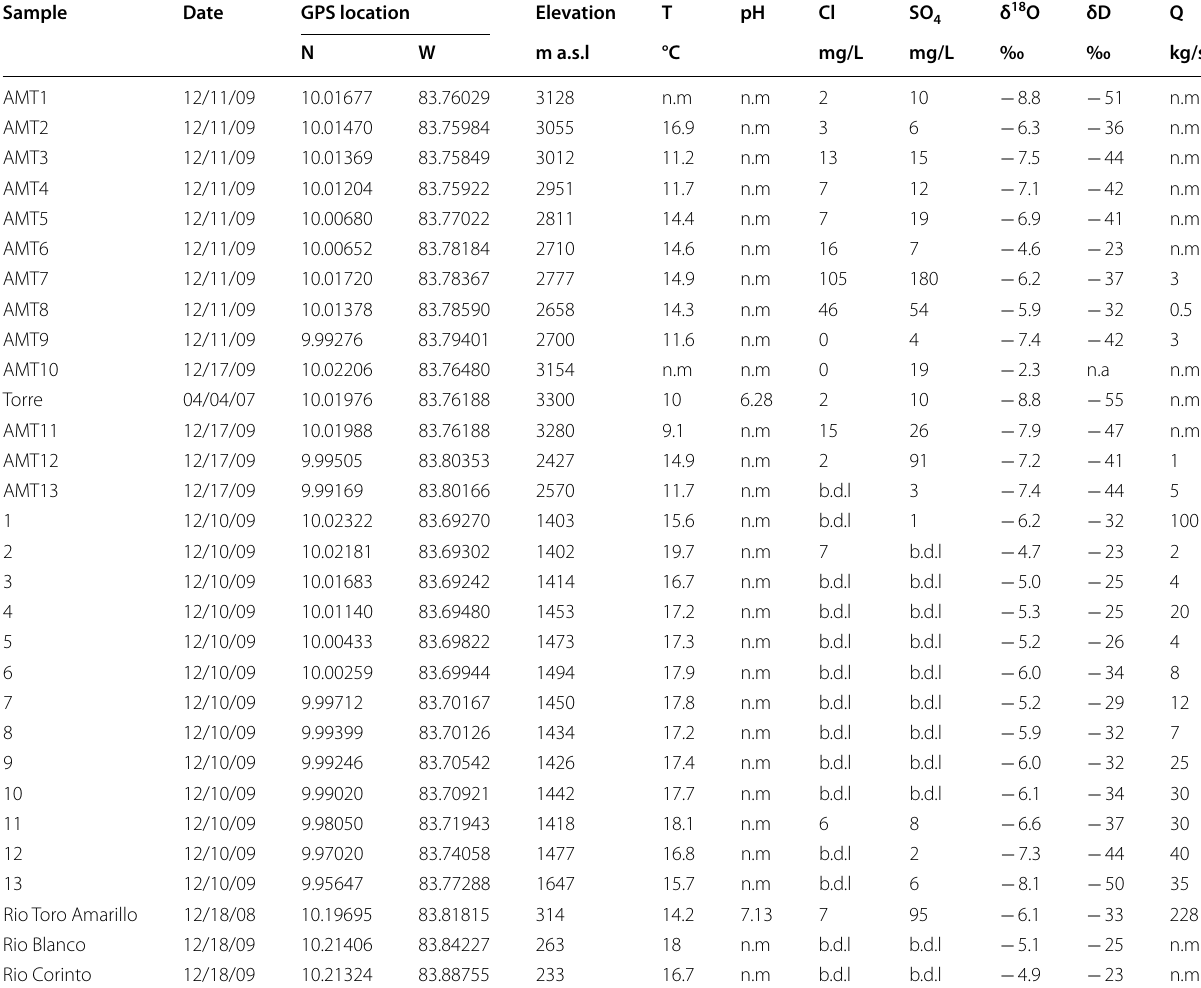
) and isotope values of meteoric waters (AM), rivers and cold springs for Turrialba (T) 4